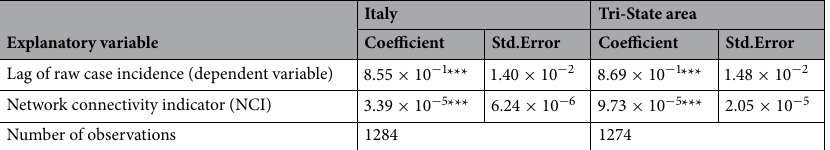
Table 2. Summary of results from the auto-regression infection generation model. Significance levels: (***)